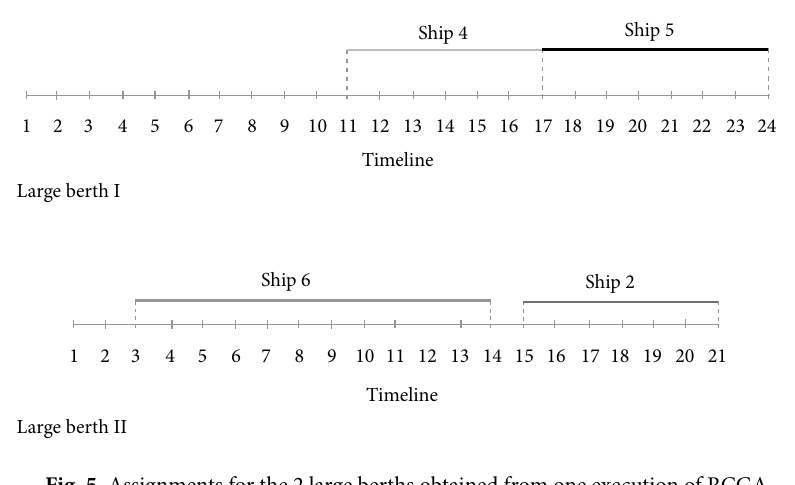
Fig. 5. Assignments for the 2 large berths obtained from one execution of RCGA